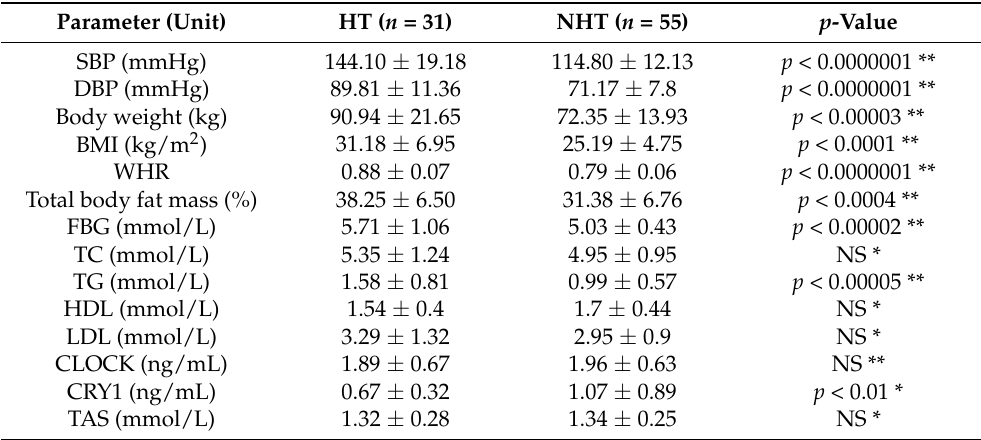
Table 1. Anthropometric and biochemical characteristics of hypertensive individuals (HT) and non-hypertensive subjects